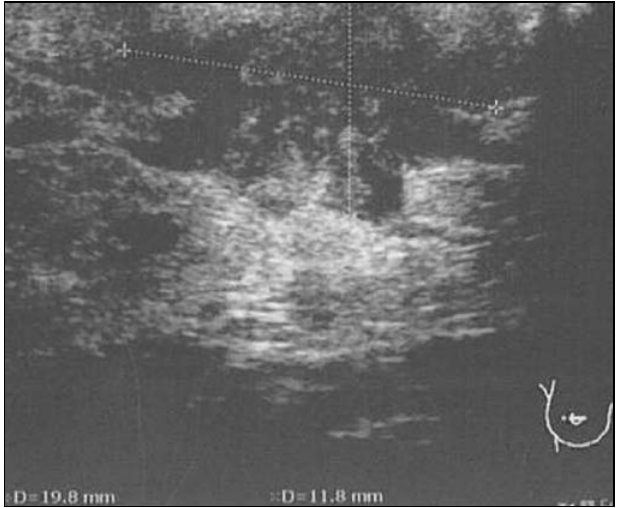
Fig. 2. Ultrasound image of the breast.